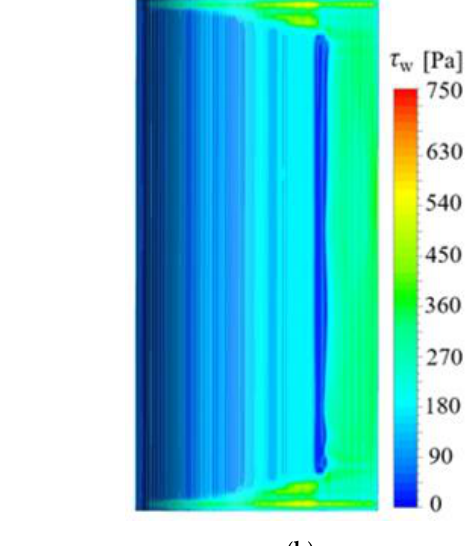
Figure 15. Local pressure and streamline distribution on the suction side. 4. Conclusions In this paper, to study the transitional prediction of the planar cascade and the variation law of the transitional location, TSP transitional measurement tests were carried out under the conditions of Ma 2 = 0.4, 1.03, and 1.2. The numerical simulations of plane cascade transition with different Ma 2 ( Ma 2 = 0.56, 0.78, 0.98, 1.1, 1.2, 1.4) and α ( α = −1 0°, 0°, 10°) were investigated. The main obtained conclusions are as follows: (1) TSP transitional measurement results show that the transitional location was about 0.63 Lax at Ma 2 = 0.4, Re 1 = 3.1 × 10 5 , and transition occurred at approximately 0.42 Lax at Ma 2 = 1.03 Re 1 = 8.6 × 10 5 . As Re 1 decreased, the transitional location moved backward, about 0.47 Lax at Ma 2 = 1.03, Re 1 = 3.1 × 10 5 . The transitional location shifted